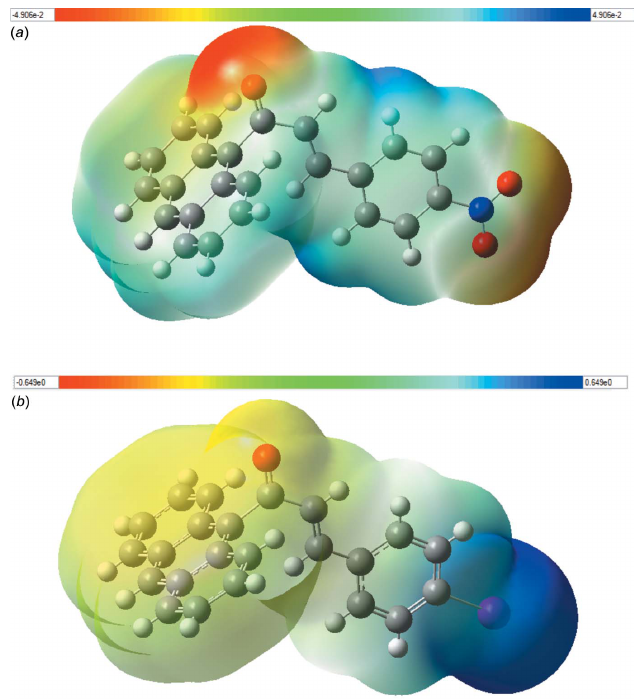
Figure 6 Three-dimensional maps of the total electron density surface of ( a ) compound (I) and ( b ) compound (II) with electrostatic potential calculated at B3LYP/6–311 G++ (d,p)